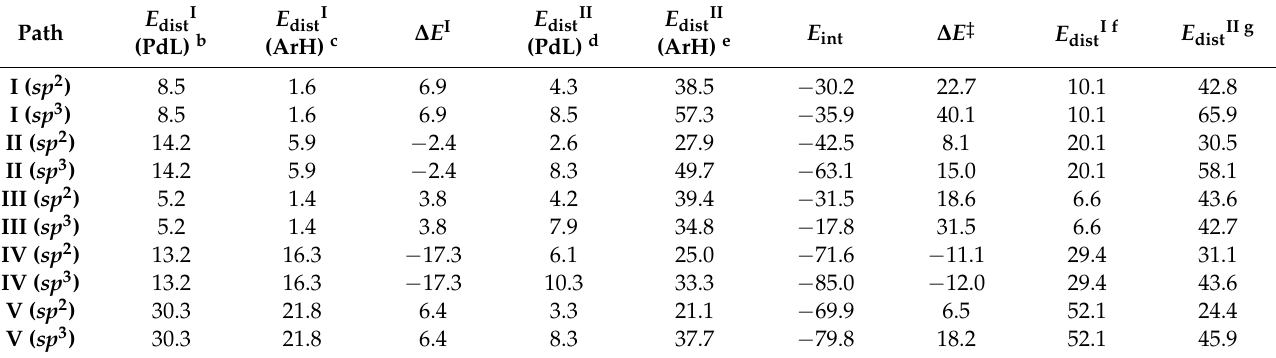
Table 4. Activation strain analysis results. Catalyst and substrate distortion energies,